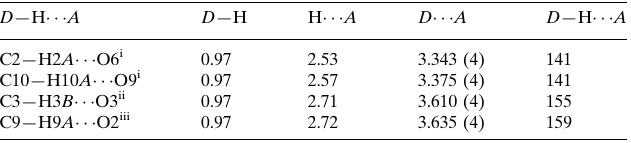
Hydrogen-bond geometry (A˚ , (cid:4)